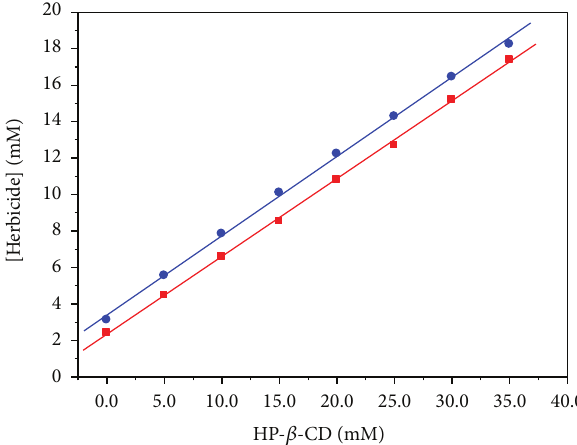
Figure 1: Phase solubility diagram obtained for herbicides (red square) MCPA and (blue circle) mecoprop and increasing concen- trations of HP- 𝛽 -CD in water at 25 ∘ C. Each point represents the mean of three